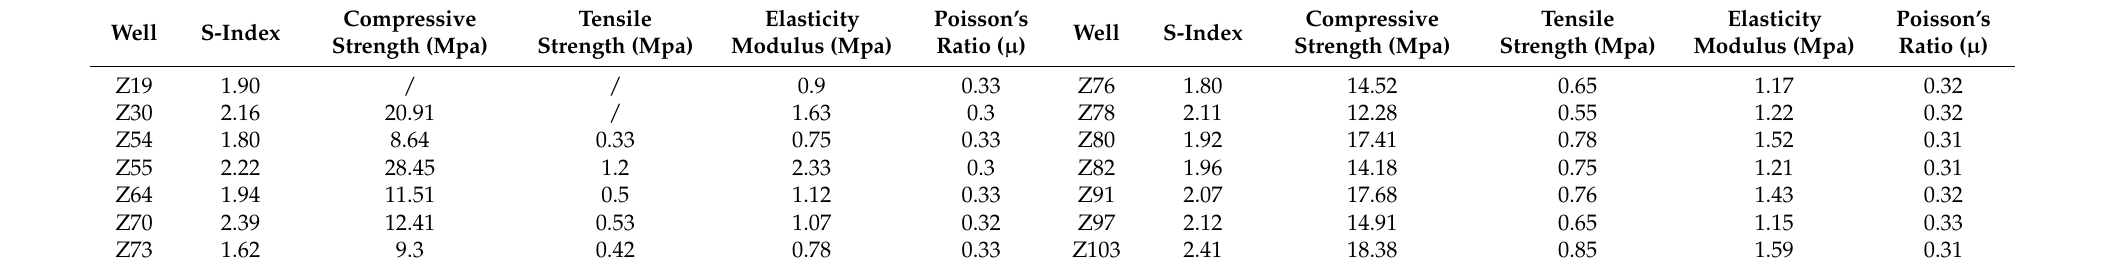
Table 7. Rock mechanical characteristics of coal and coal roof and